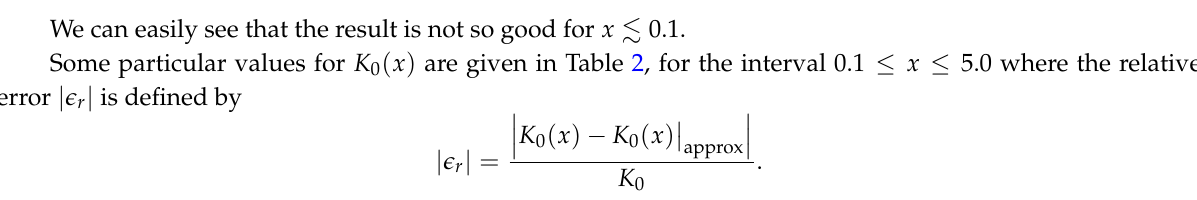
Figure 1. Comparison between the Bessel function K 0 ( x ) and its expansion (5) for different values of n .